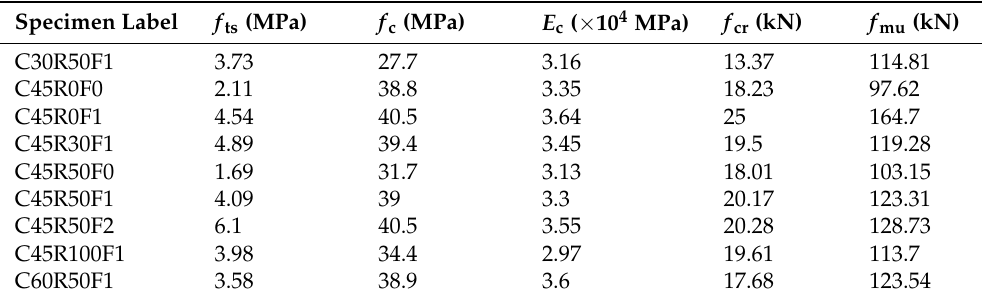
Table 4. Beam cracking load, ultimate load, and basic mechanical properties of concrete.